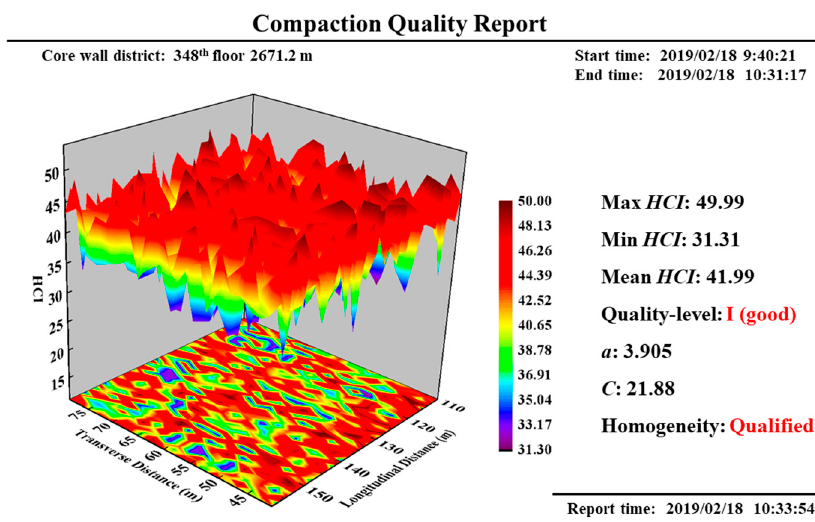
Figure 10. Compaction quality report of randomly selected working face.